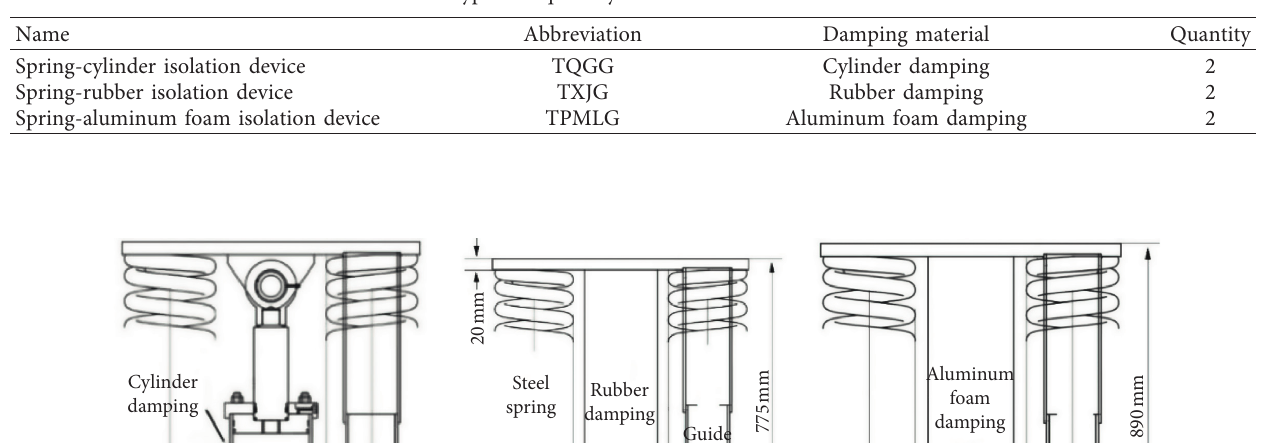
Table 1: Type and quantity of combined isolation devices.